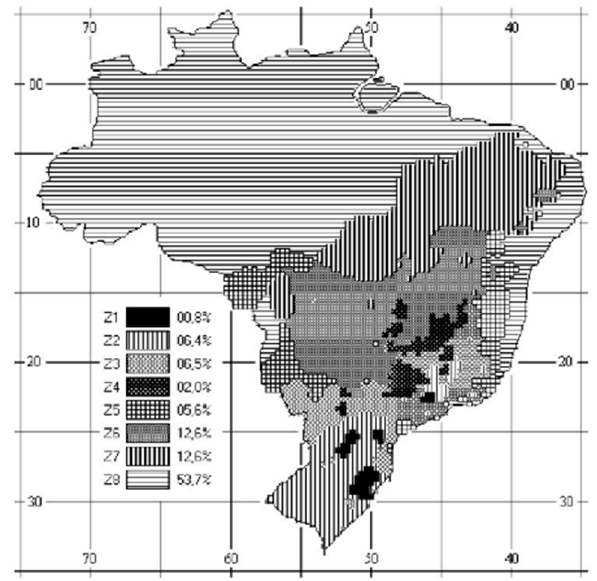
Figure 2. Brazilian climatic zones given by Reference [13]. Table 6. Criteria for the simplified procedure.